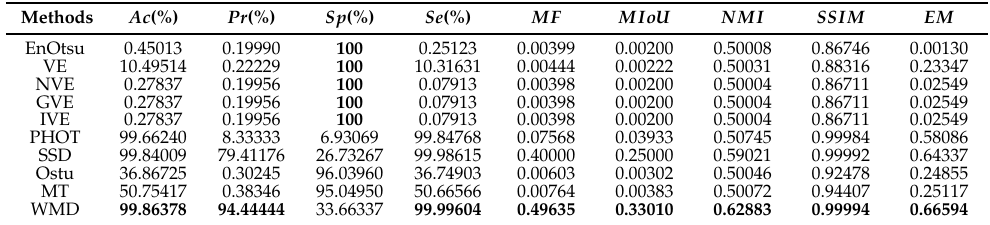
Figure 12. Quantitative comparison in terms of (a) Ac (%), ( b ) Sp (%), ( c ) Se (%), ( d ) MF , ( e ) MIoU , ( f ) MI , ( g ) NMI , ( h ) SSIM , and ( i ) EM , where the x axis is the Image ID. Our method (WMD) significantly outperforms these evaluated defect detection algorithms across ten randomly selected surface defect detection images. Table 1. Results on the magnetic tile image in terms of Ac (%), Pr (%), Sp (%), Se (%), MF , MIoU , MI , NMI , SSIM , and EM